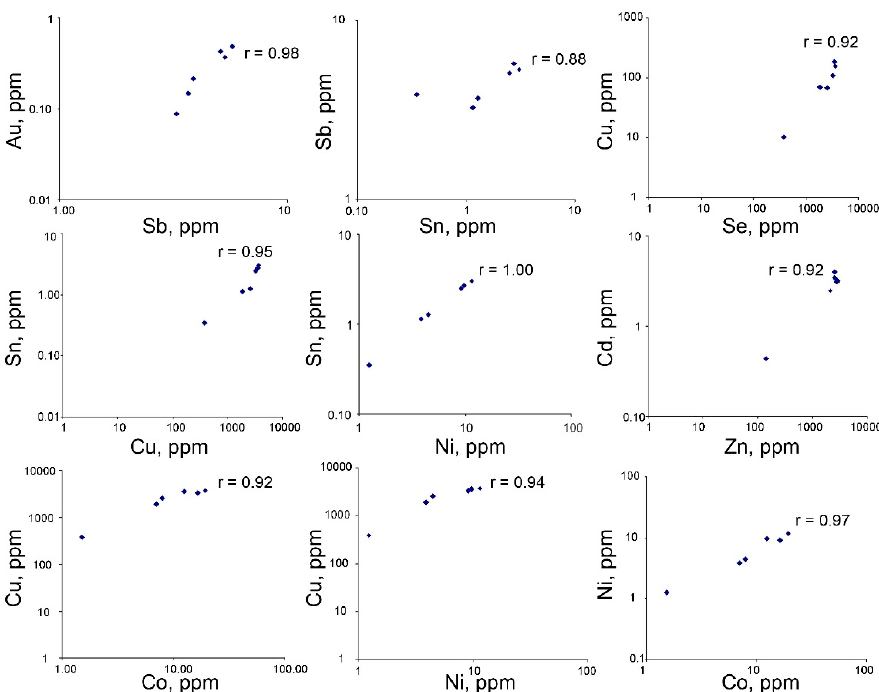
Figure 8. Log ‐ log plots for selected trace elements in ovoid fine ‐ crystalline pyrite (ppm). Here and in Figures 9 and 11, correlation coefficients are taken from correlation matrices (Supplementary Materials).